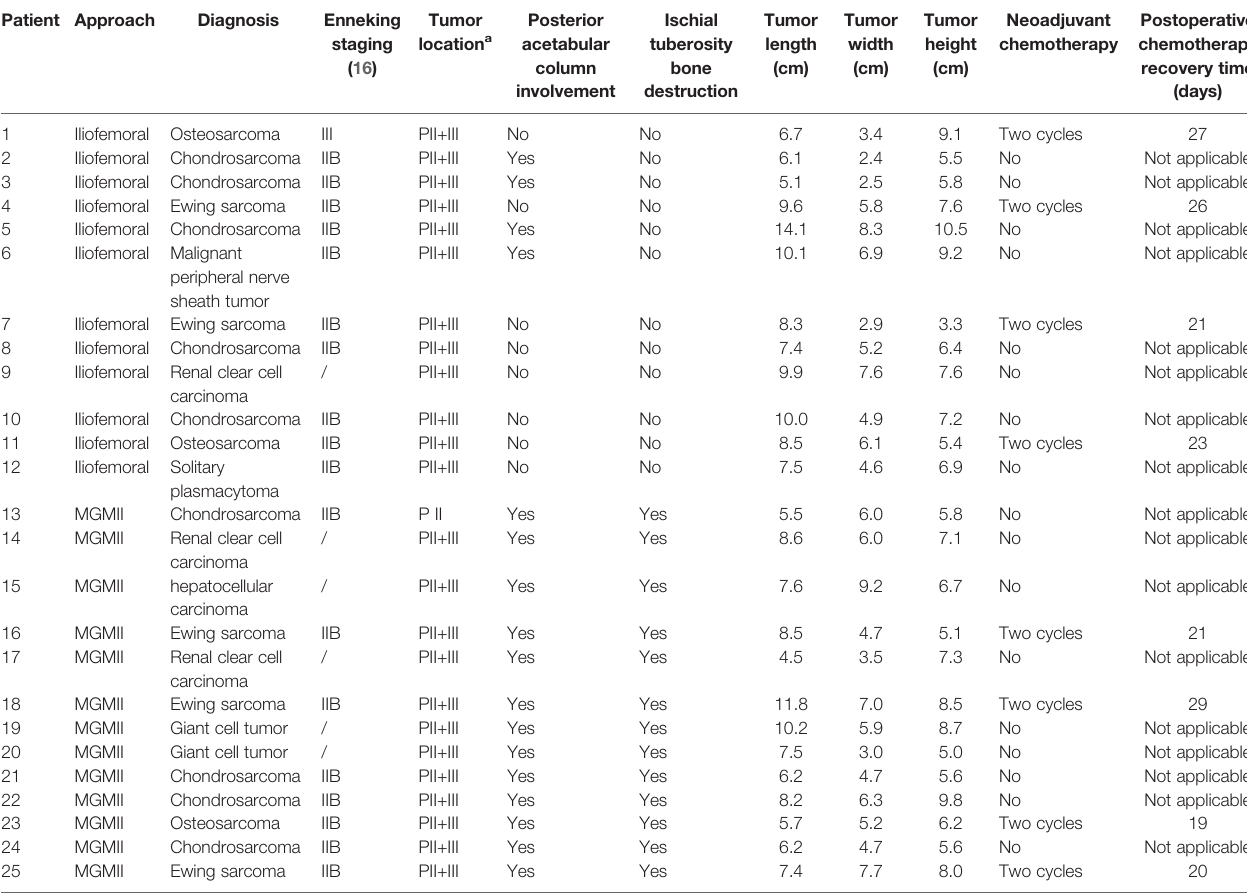
TABLE 2 | Preoperative oncologic characteristics of 25 patients treated with 3D-printed custom-made integrative hemipelvic endoprostheses via two approaches. Patient Approach